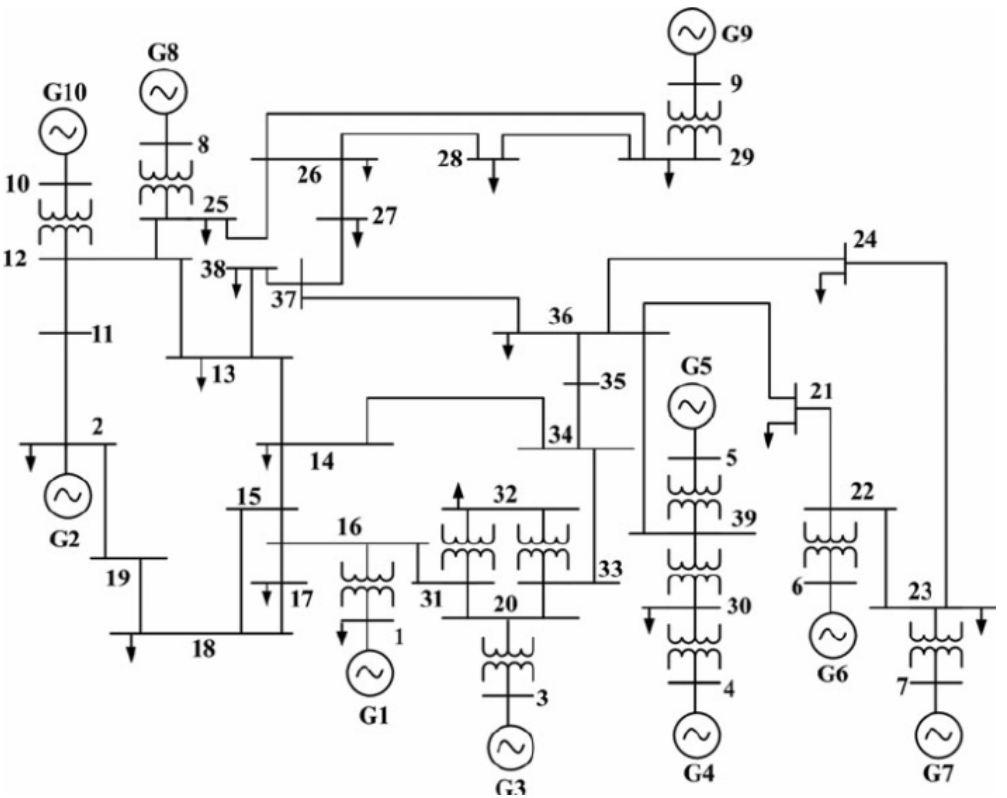
Figure 13. IEEE 39 bus testing system. Figure 13. Voltage profile of New England system.